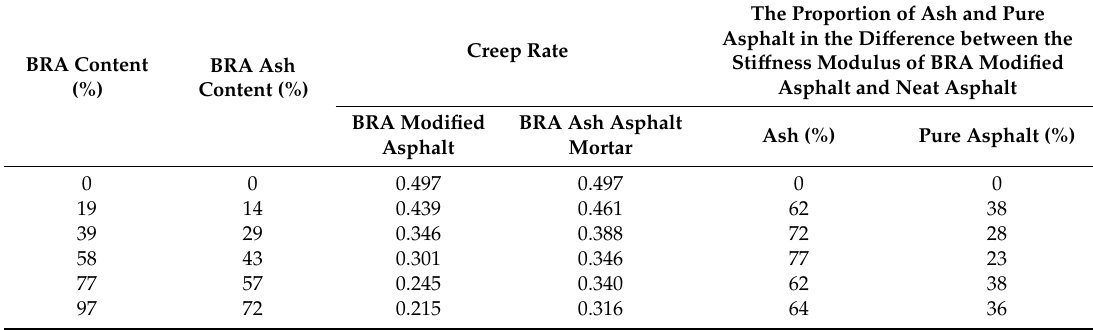
Table 18. Percentage of sti ff ness modulus of di ff erent components in BRA at − 12 ◦ C. BRA Content BRA Ash (%) Content (%)